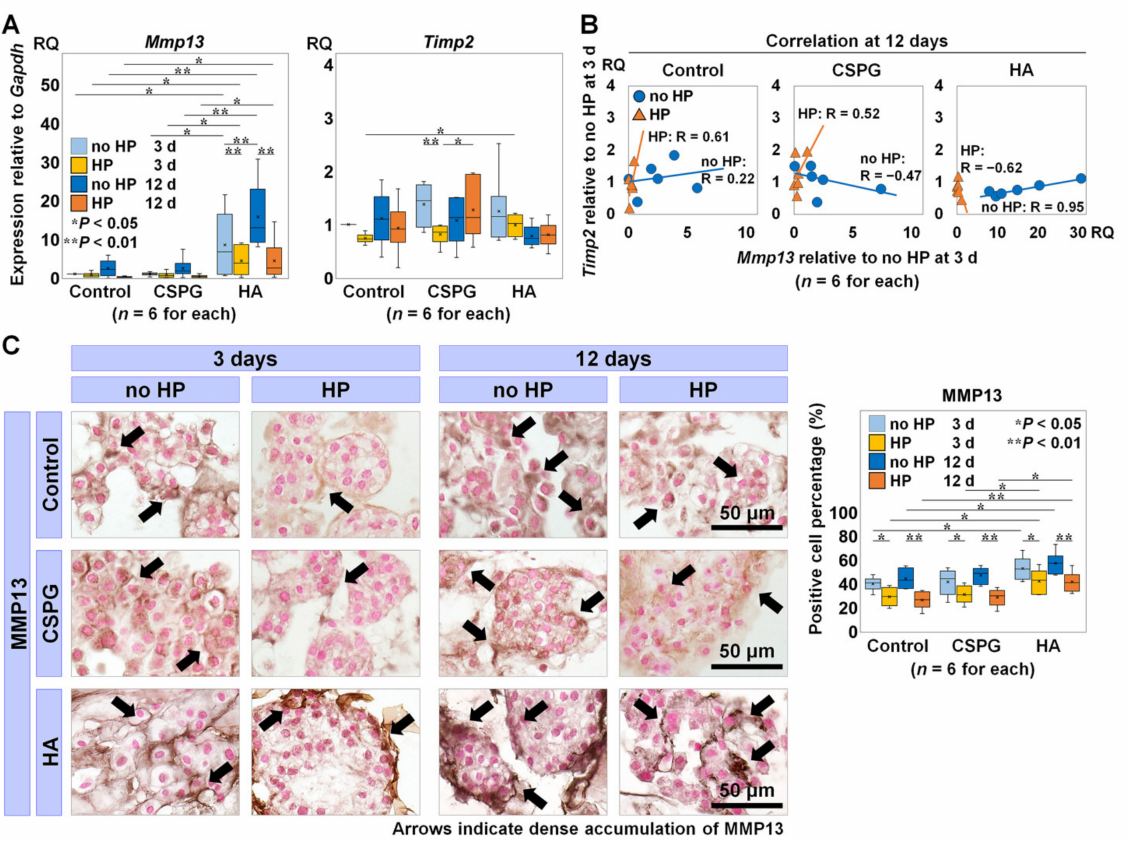
Figure 2. The effects of augmenting extracellular matrix (ECM) on catabolic turnover in bovine nucleus pulposus (bNP) cells under hydrostatic pressure (HP). ( A ) Gene expressions of catabolic matrix metalloproteinase 13 ( Mmp13 ) and anti-catabolic tissue inhibitor of metalloproteinases 2 ( Timp2 ) with the no-material control, chondroitin sulfate proteoglycan (CSPG), and hyaluronan (HA) under no HP and HP at 3 and 12 days relative to the control under no HP at 3 days ( n = 6 for each). Data are presented with box plots. Multi-way repeated measures analysis of variance (ANOVA) with the Bonferroni post hoc test was used. * p < 0.05 and ** p < 0.01. Gapdh , glyceraldehyde 3-phosphate dehydrogenase . RQ, relative quantity. ( B ) The correlation between Mmp13 and Timp2 expression with the control, CSPG, and HA under no HP and HP at 12 days relative to the control under no HP at 3 days ( n = 6 for each). Pearson correlation analysis was used. ( C ) The accumulation of MMP13 in black counterstained with Contrast Red and positive cell percentage of MMP13 ( n = 6 for each). Arrows indicate intense accumulation, each section is 7 µ m thick, and the bar indicates 50 µ m. Data are presented with box plots. Multi-way repeated measures ANOVA with the Bonferroni post hoc test was used. * p < 0.05 and ** p <